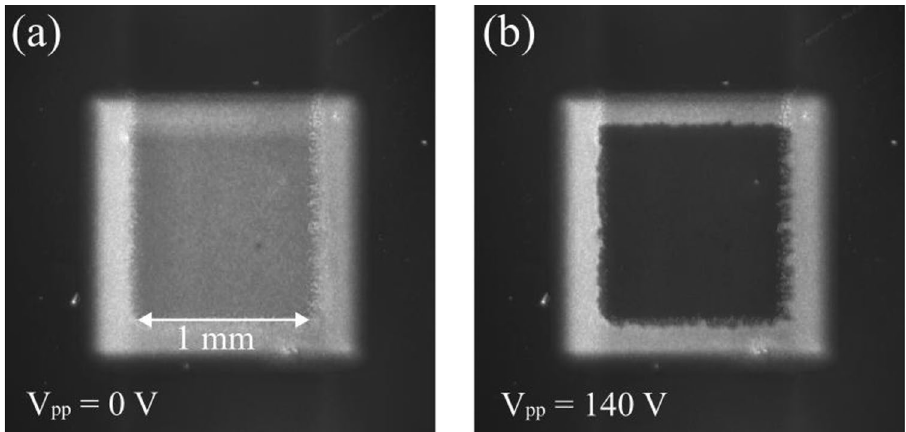
Figure 5. Cross-polarised microscope images of the PDLC: ( a ) with no applied AC voltage; ( b ) with and applied AC voltage of 140 V.